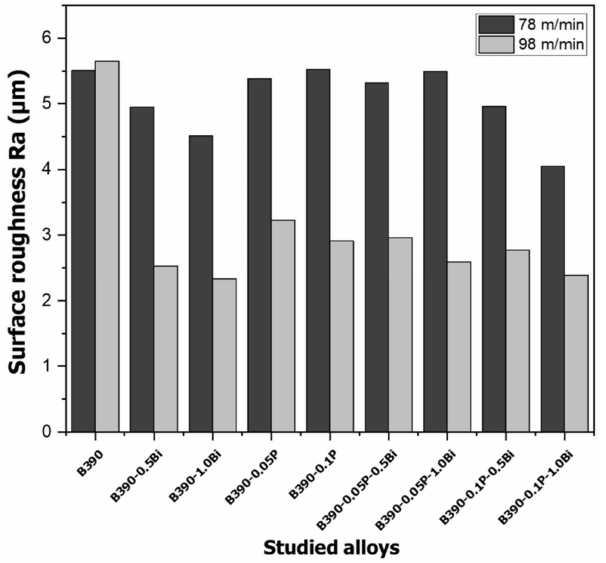
Figure 15. Average surface roughness Ra ( µ m) at unmodified and modified as-cast